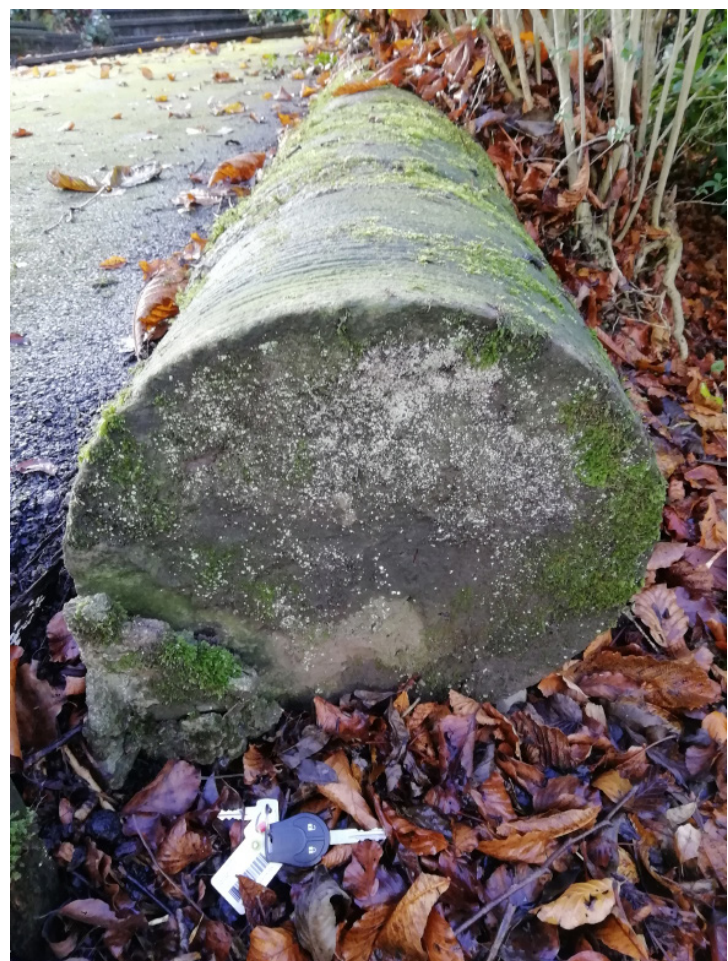
Figure 2. Sections of the Barnoldswick Waterworks Borehole core being utilized as path edging in the Letcliffe Park recre- ation